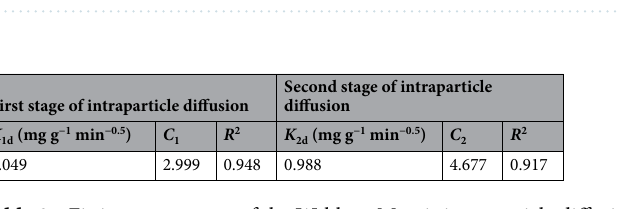
Table 8. Fitting parameters of the Webber–Morris intraparticle diffusion